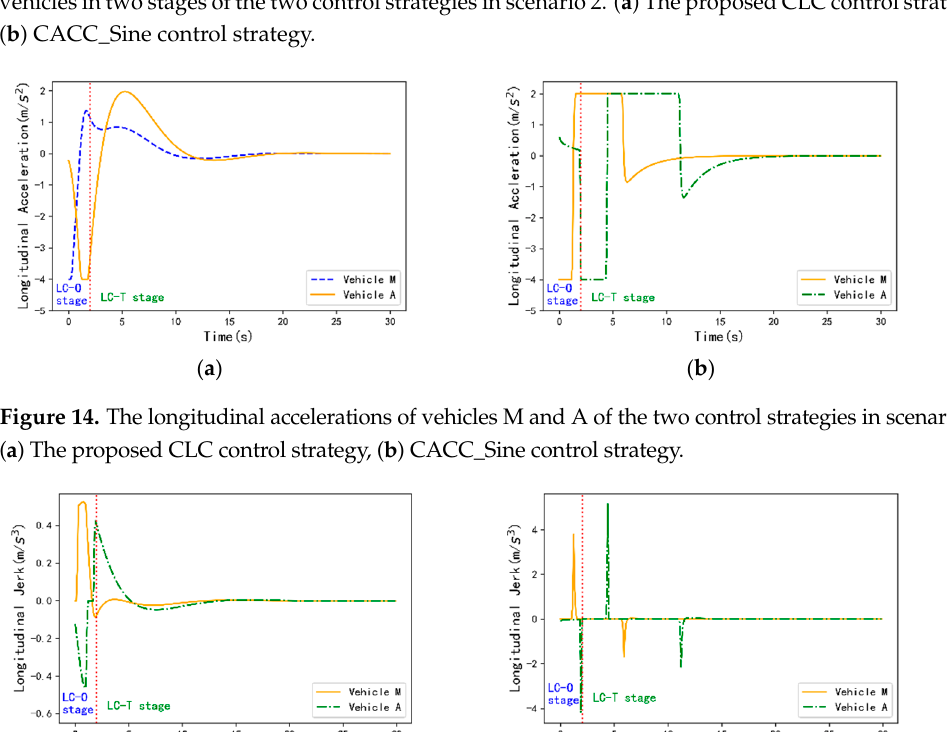
Figure 13. The Actual and Expected longitudinal distances between vehicles M, A and their preceding vehicles in two stages of the two control strategies in scenario 2. ( a ) The proposed CLC control strategy, ( b ) CACC_Sine control strategy.